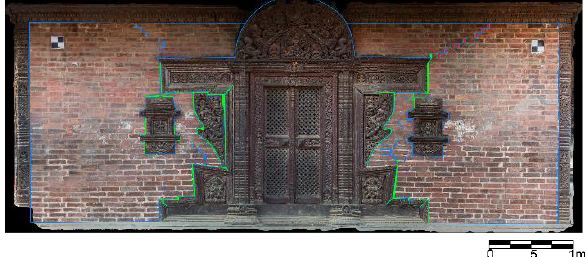
Figure 12. Mapping of existing cracks in structural wall